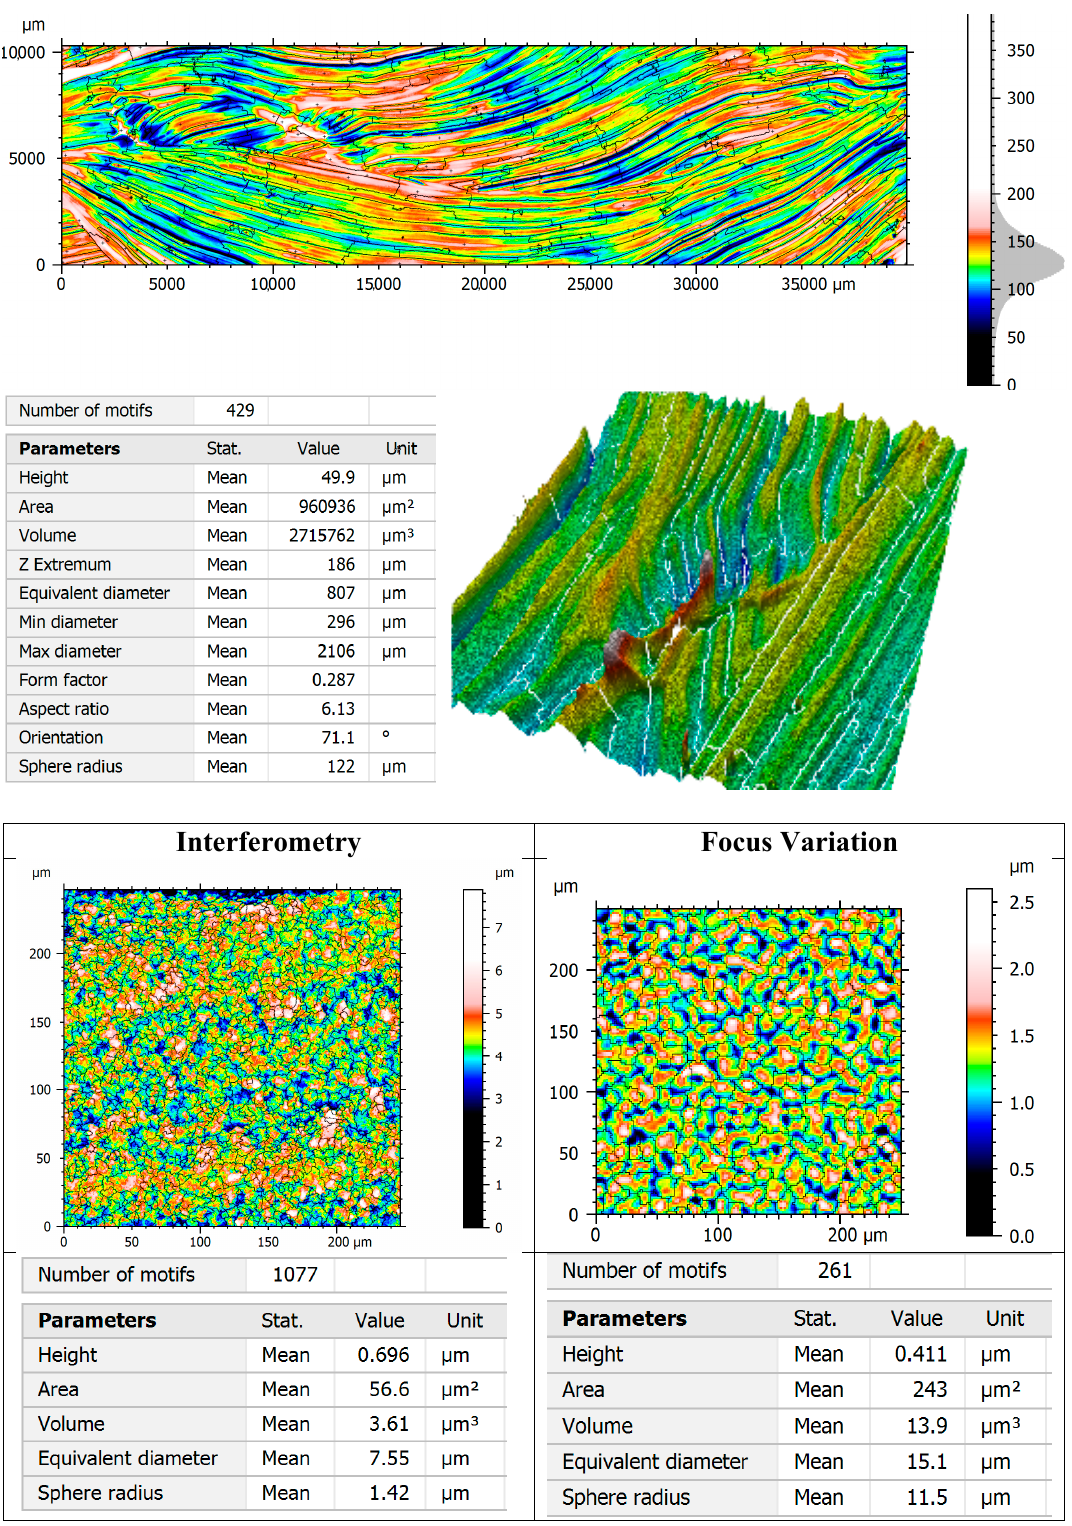
Figure A2. Segmentation by the Wolf pruning algorithm of the topographic map shown in Figure A1.